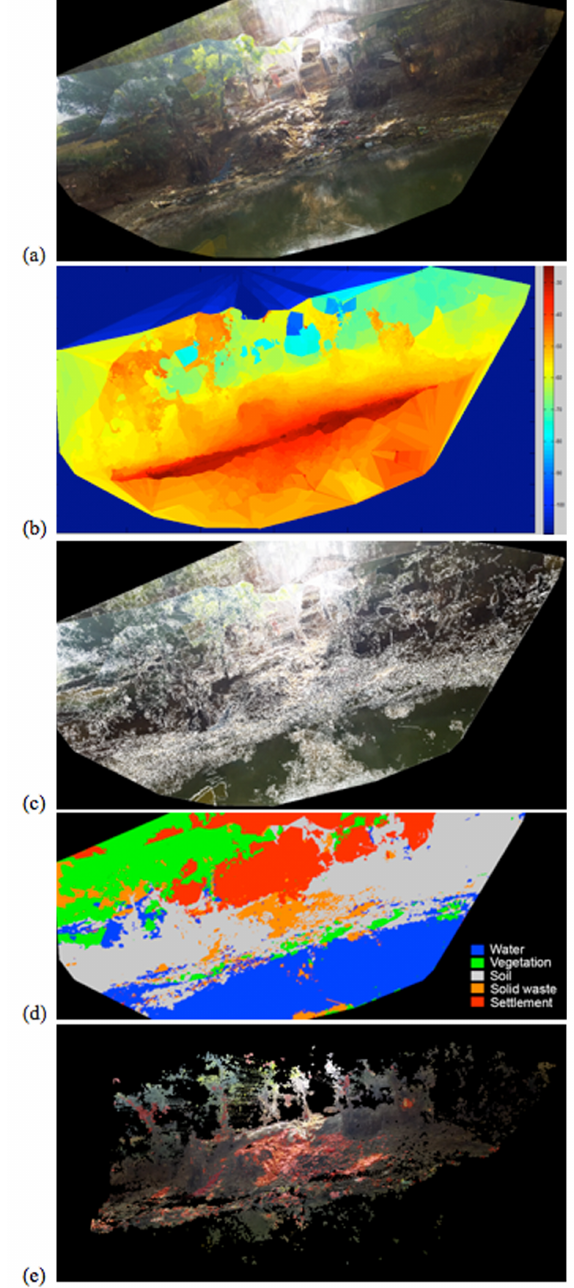
Figure 4: (a) View dependent orthophoto, (b) depth image, (c) segmentation boundaries, (d) classification results and (e) colour point cloud where solid waste is labelled